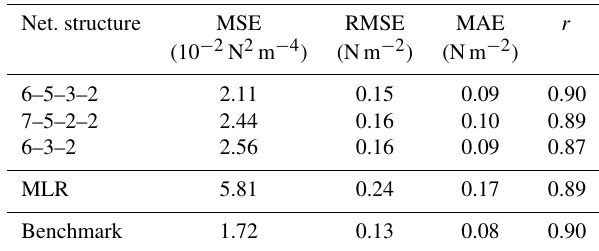
Table 5. Performance of networks vs. multivariate linear regression (MLR) and the MOST method (“Benchmark”) for momentum flux at the DE-Keh